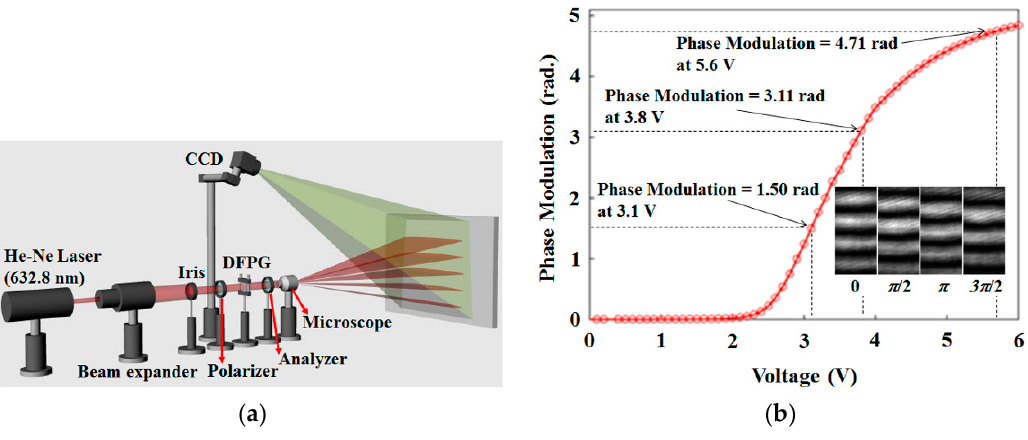
Figure 6. ( a ) Optical system for measuring phase modulation values of the common slit according to an applied voltage and their moving fringe patterns; ( b ) Measured phase modulation curve according to an applied voltage and the fringe patterns captured under Δφ = 0, π /2, π , and 3 π /2